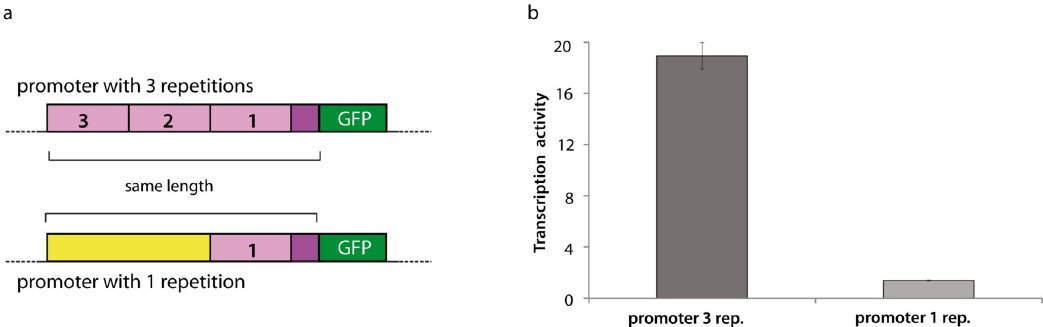
Fig 10. In vivo experimental validation in P . falciparum . a Schematic of the chimeric promoters used in our report assay to monitor promoter activity. b Transcriptional activity quatification by qPCR analysis of RNA collected at ring stages parasites. Here, one representative transgenic parasite clone. See Materials and methods for